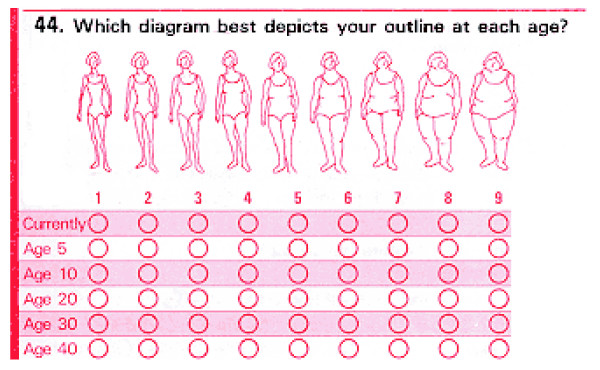
Figure drawing 24 used to assess body fatness at different ages among Nurses' Health Study II participants.